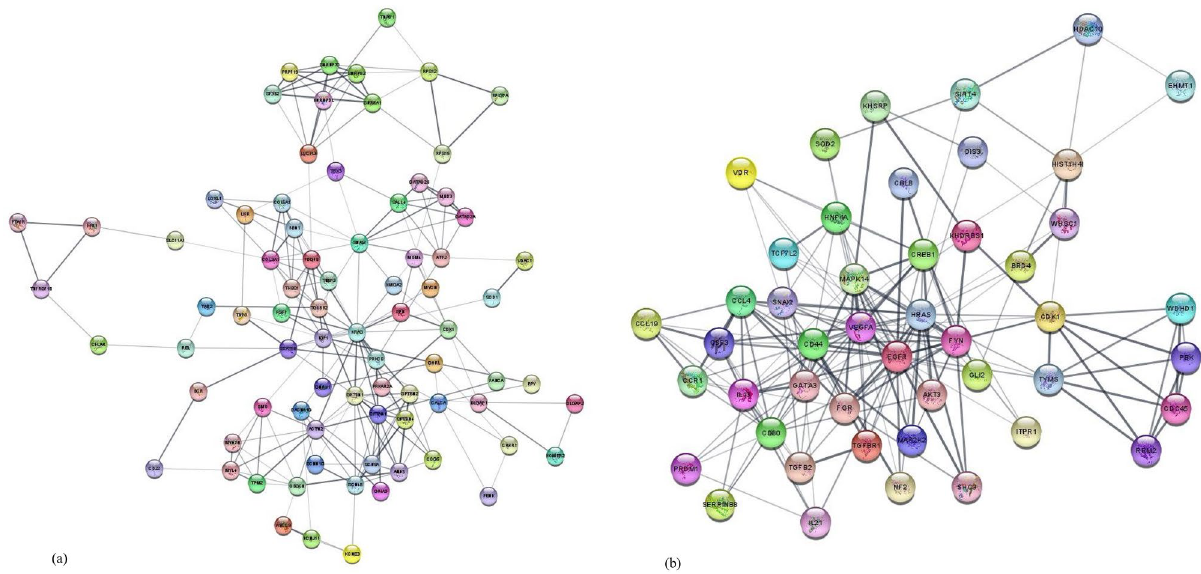
Figure 7. Differentially expressed genes protein–protein interaction with ( a ) SOD1 and ( b )